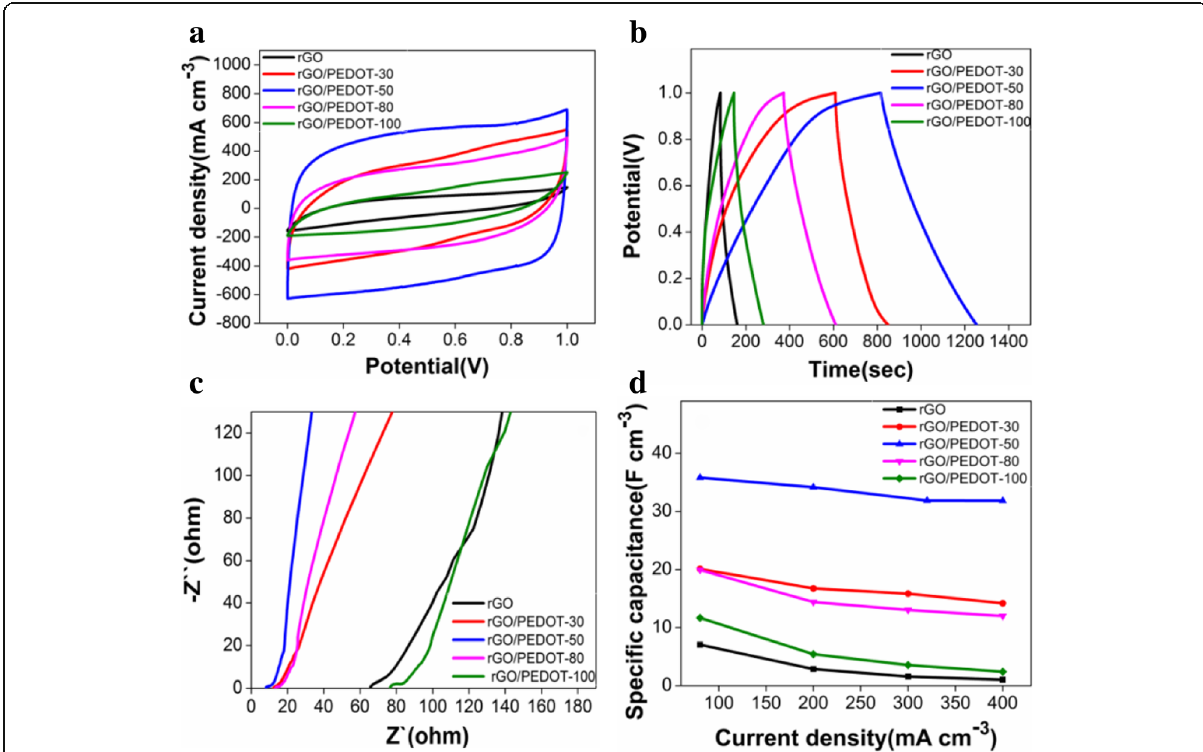
Fig. 5 The compared electrochemical properties of various rGO/PEDOT composites with different reaction temperature-based MSCs: a CV curves at 20 mV s − 1 and b GCD curves at 80 mA cm − 3 . c Nyquist plots from the EIS analysis obtained from 0.01 Hz to 100 kHz. d Specific capacitance versus different current